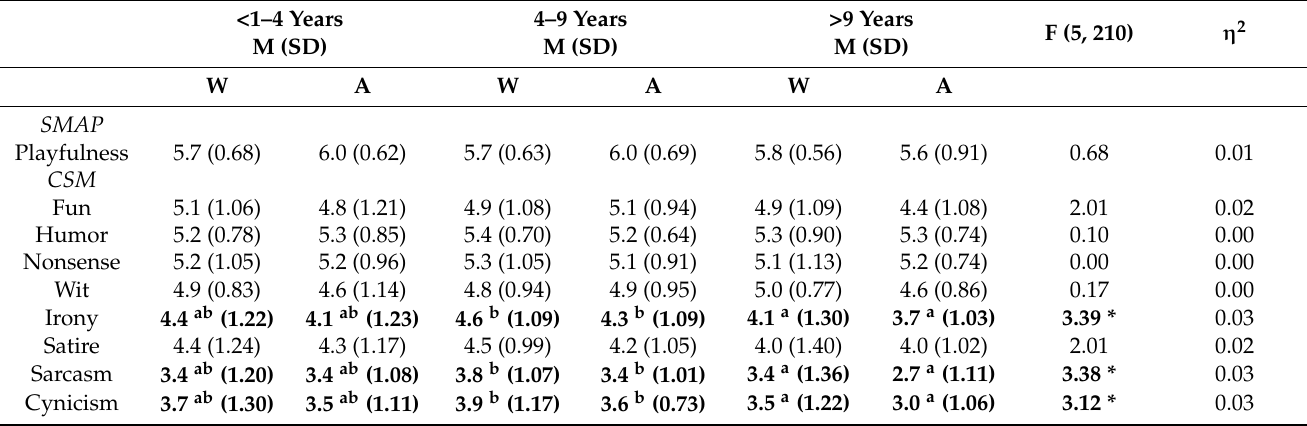
Table 1. Mean scores and standard deviations (in parentheses) of Experience/Characters and